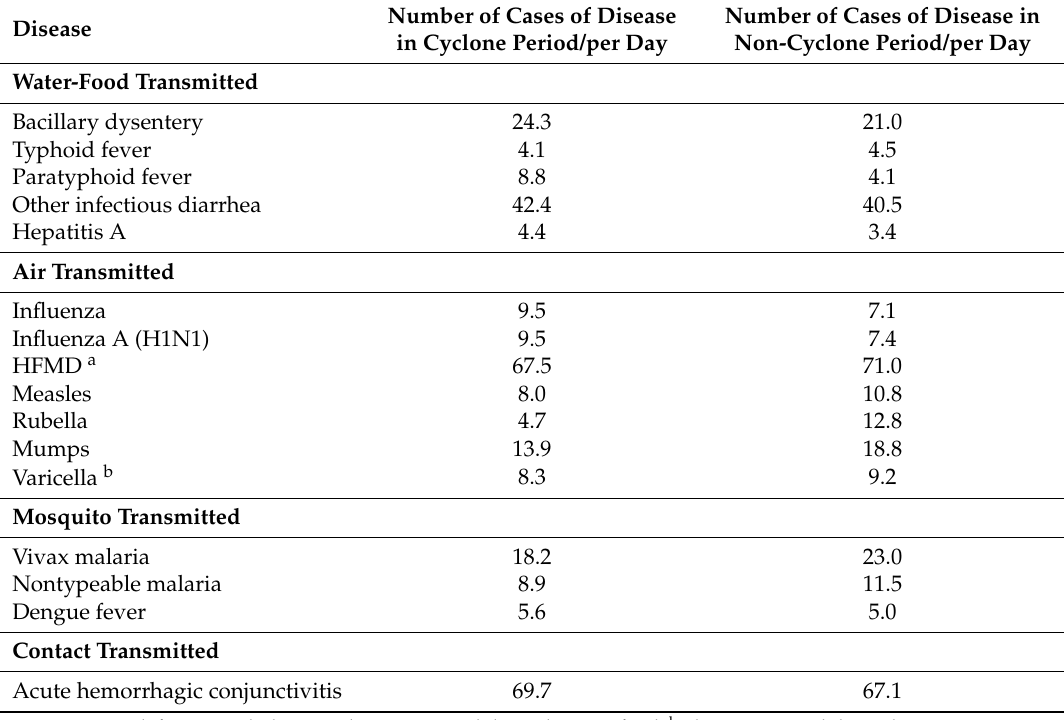
Table 3. Average number of cases per day for different infectious diseases in the study